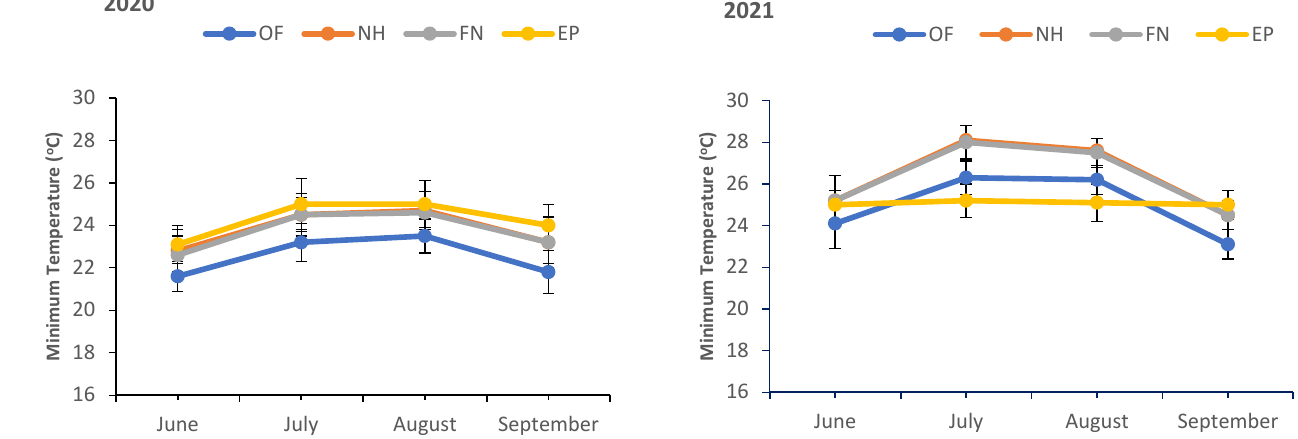
Figure 5. Average monthly minimum temperature during the experiment periods of 2020 and 2021 seasons, registered in the open field (OF), net house (NH), net house with fogging (NF, operating 6 S/36 S from 10 a.m. to 4 p.m.) and evaporative cooling under plastic house (EP). Standard error of the means was derived from three biological replicates.